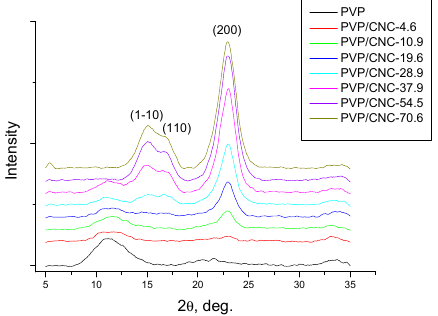
Figure 6. X-ray diffraction patterns of the PVP/CNC composite films.